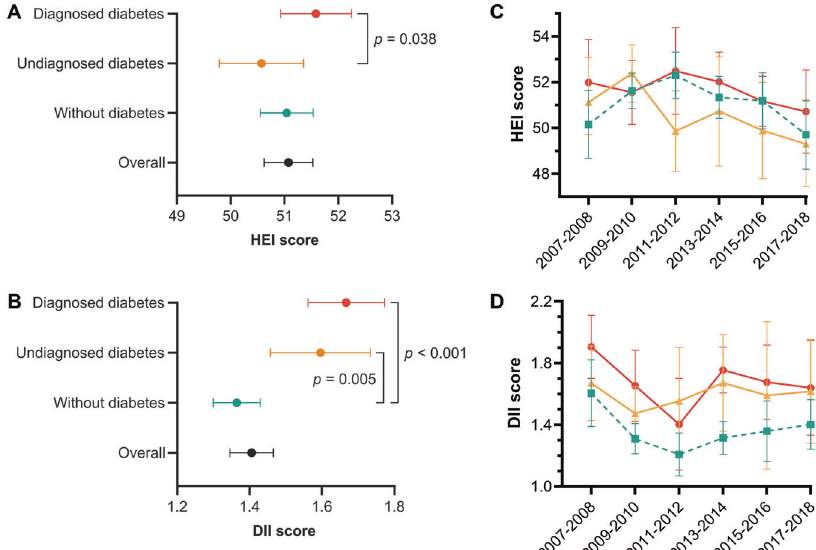
Fig. 1 Comparison of dietary scores of general Americans by baseline diabetes diagnoses. A Comparison of the overall HEI score according to different diabetes diagnoses; B Comparison of the overall DII score according to different diabetes diagnoses; C US Trends in HEI over the last decade by baseline diabetes diagnoses; D US Trends in DII over the last decade by baseline diabetes diagnoses. The dots presented the weighted mean and the lines were the 95% con fi dence interval. The diagnosed diabetes group was depicted in red, while the groups with undiagnosed diabetes group and no diabetes were plotted in yellow and green, respectively. DII dietary in fl ammatory index, HEI healthy eating